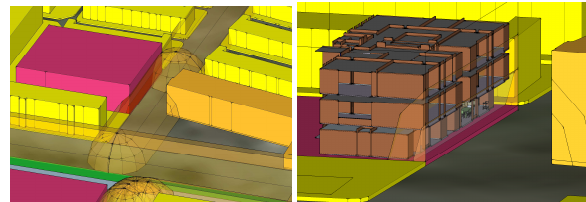
Figure 8. Sound pressure levels in 3D (left) and a building designed accordingly (right)